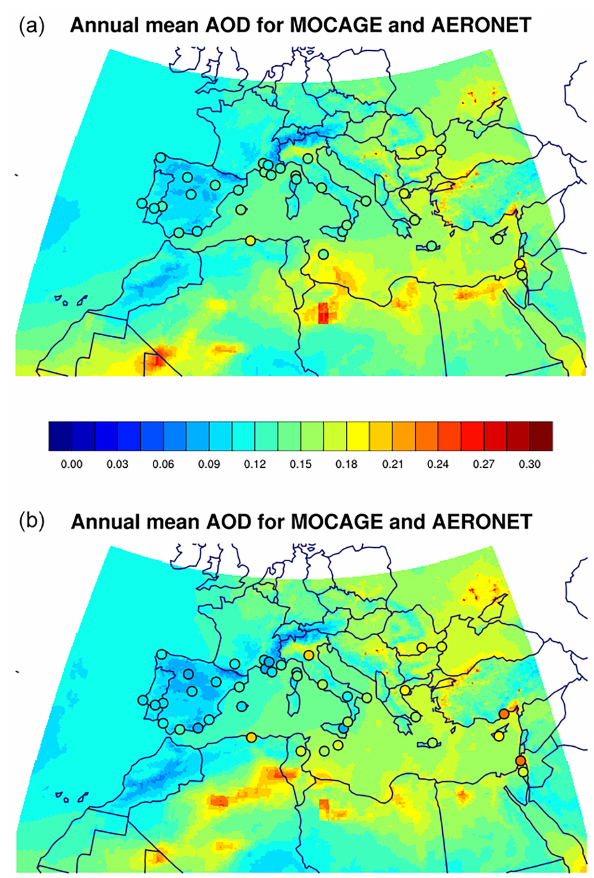
Figure 2. Map of the annual mean aerosol optical depth simulated with the model MOCAGE with superimposed AERONET observa- tions (circles) for the years 2012 (a) and 2013 (b) .